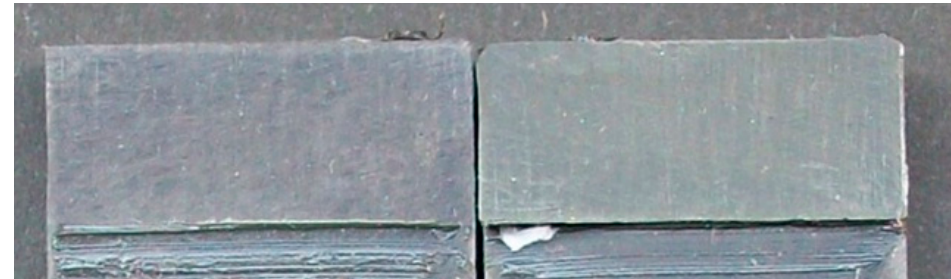
Figure 9. Fracture surface of the abraded specimen subjected to the quasi-static tensile test.